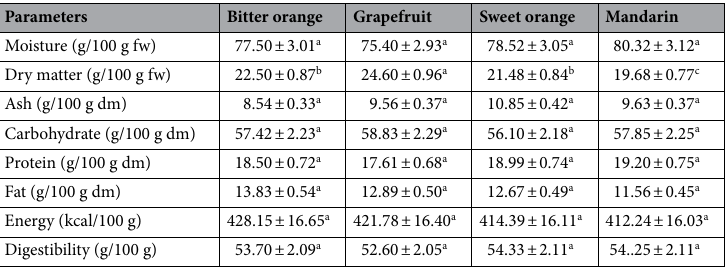
Parameters Bitter orange Grapefruit Sweet